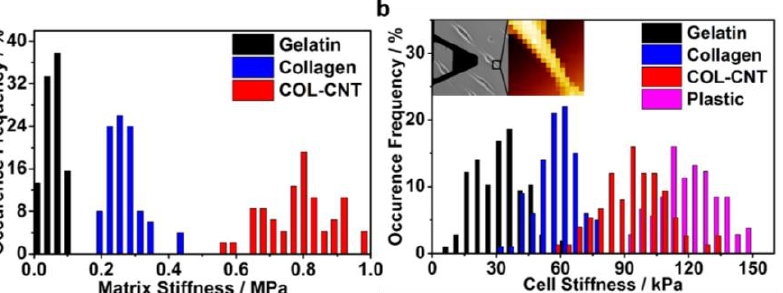
Figure 3. Statistical analyses of matrix stiffness and cell stiffness. ( a ) Histogram of E-value distribution for the matrices; ( b ) histogram of E-value distribution for cells cultured on the matrices for 3 days. The insets illustrate the phase-image-assisted elasticity measurement at the stress fiber-rich region of a targeted cell. Dimension of the phase image (left): 450 × 450 µm 2 ; dimension of the force map (right): 35 × 35 µm 2 .